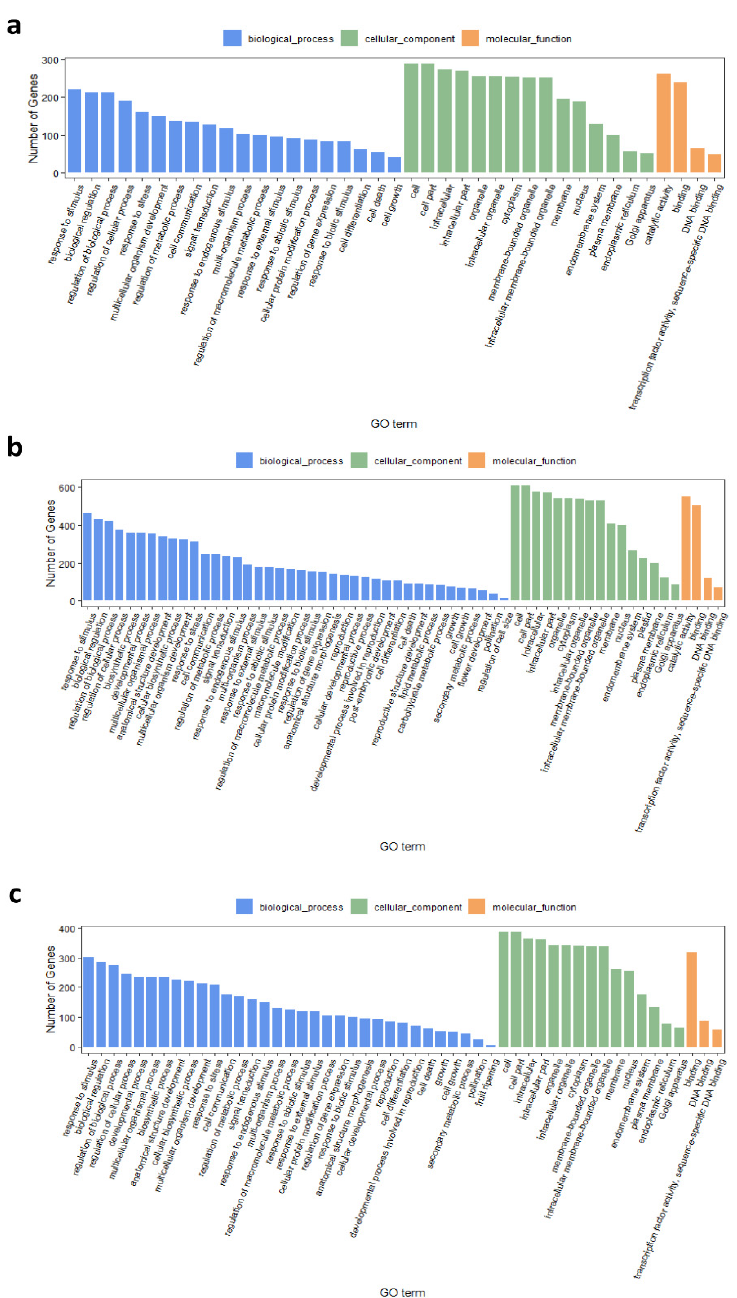
Figure 5. GO term enrichment of common DEGs from R6 and S8 at multiple timepoints. ( a ) GO term enrichment of overlap common DEGs between R6 and S8. ( b ) GO term enrichment of specific common DEGs from R6. ( c ) GO term enrichment of specific common DEGs from S8.